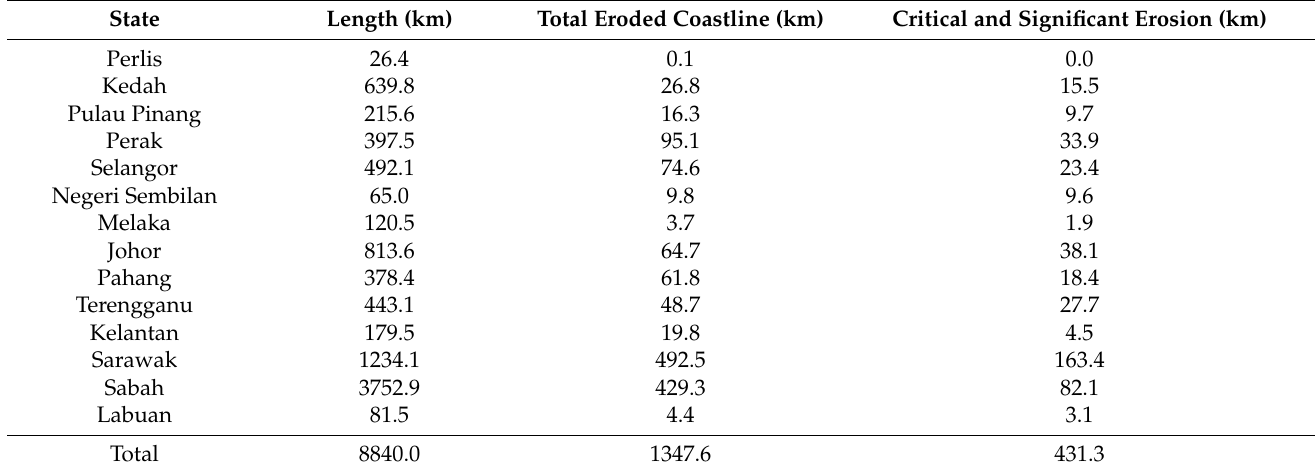
Table 2. Coastline erosion condition in 2015 as reported by [68]. ‘Reproduced from Report on National Coastal Erosion Study, 2015; published by Department of Drainage and Irrigation,